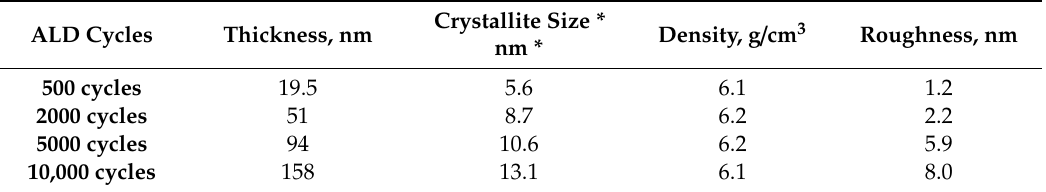
Table 1. X-ray reflectivity analysis results of thickness, crystallite size, density, and roughness (with standard deviations) of the CuO films on Si/SiO 2 substrate.